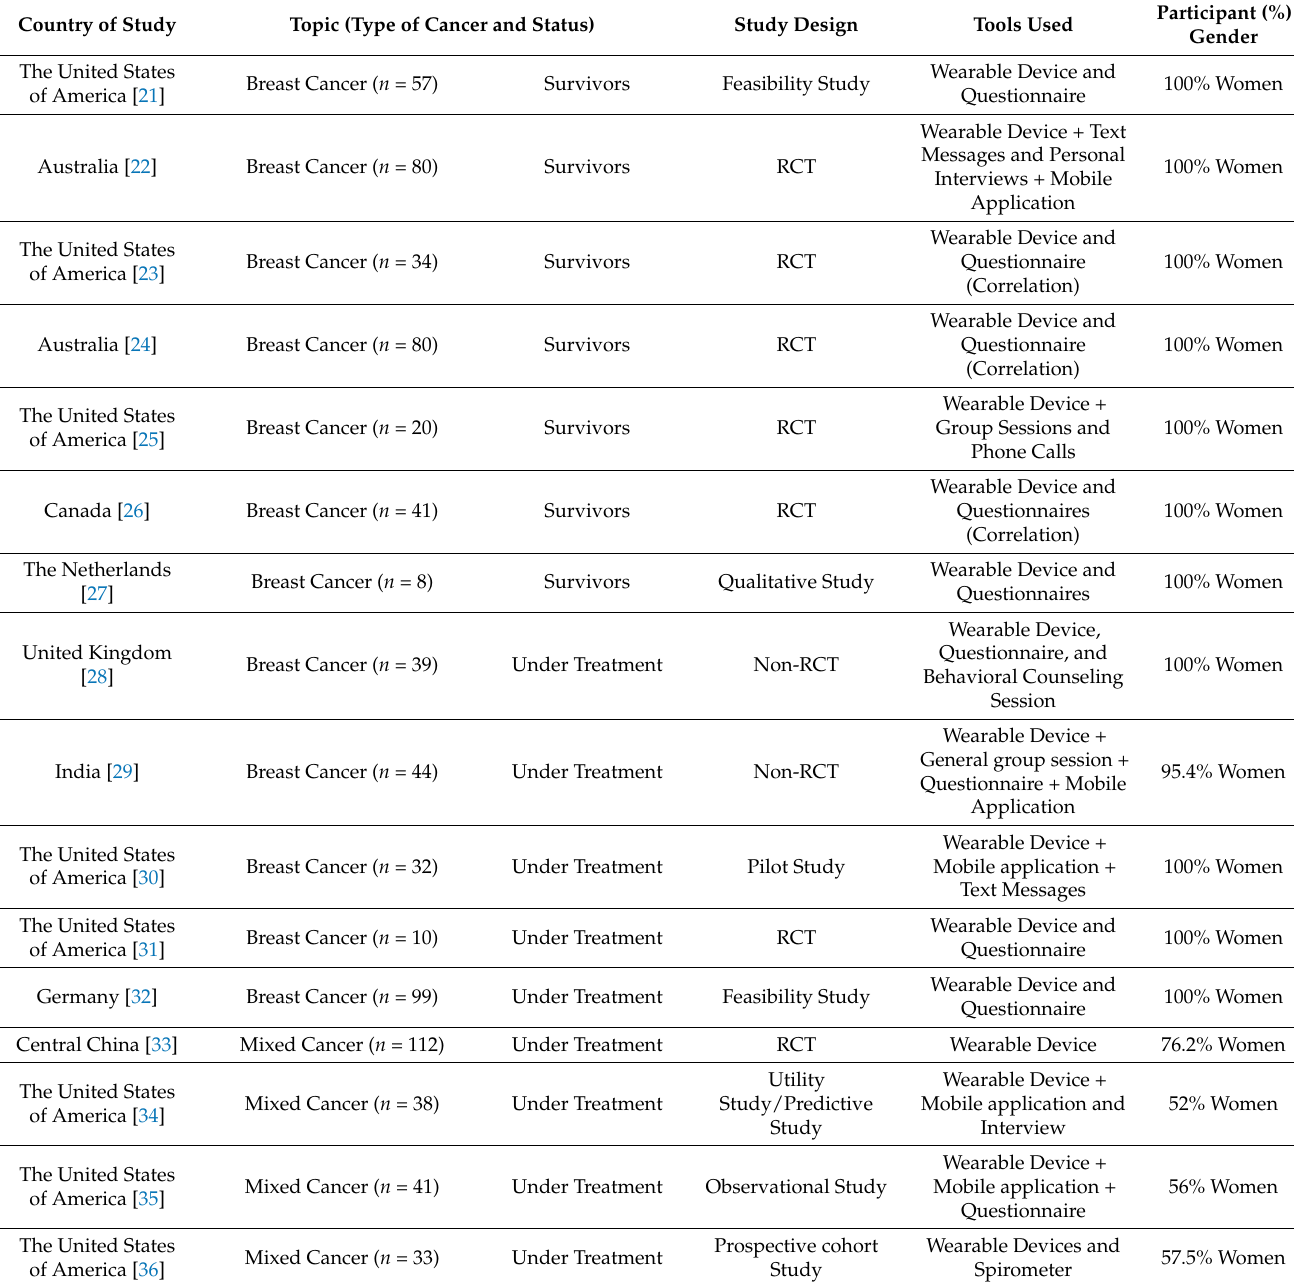
Table 1. Summary of Included